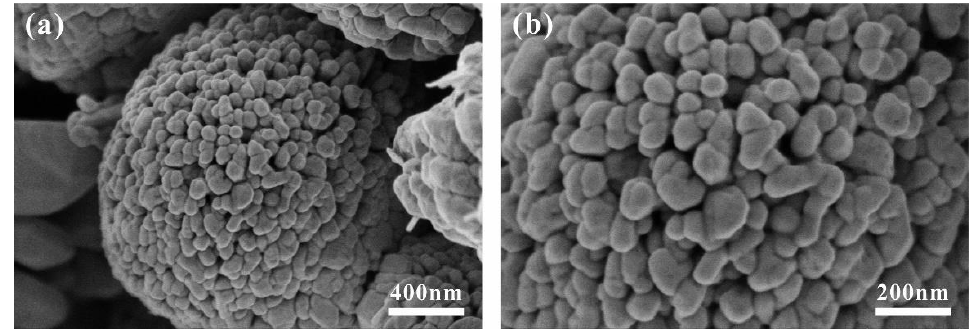
Figure 2. SEM images (( a ) low maginification; ( b ) high magnification) of BVO sample.